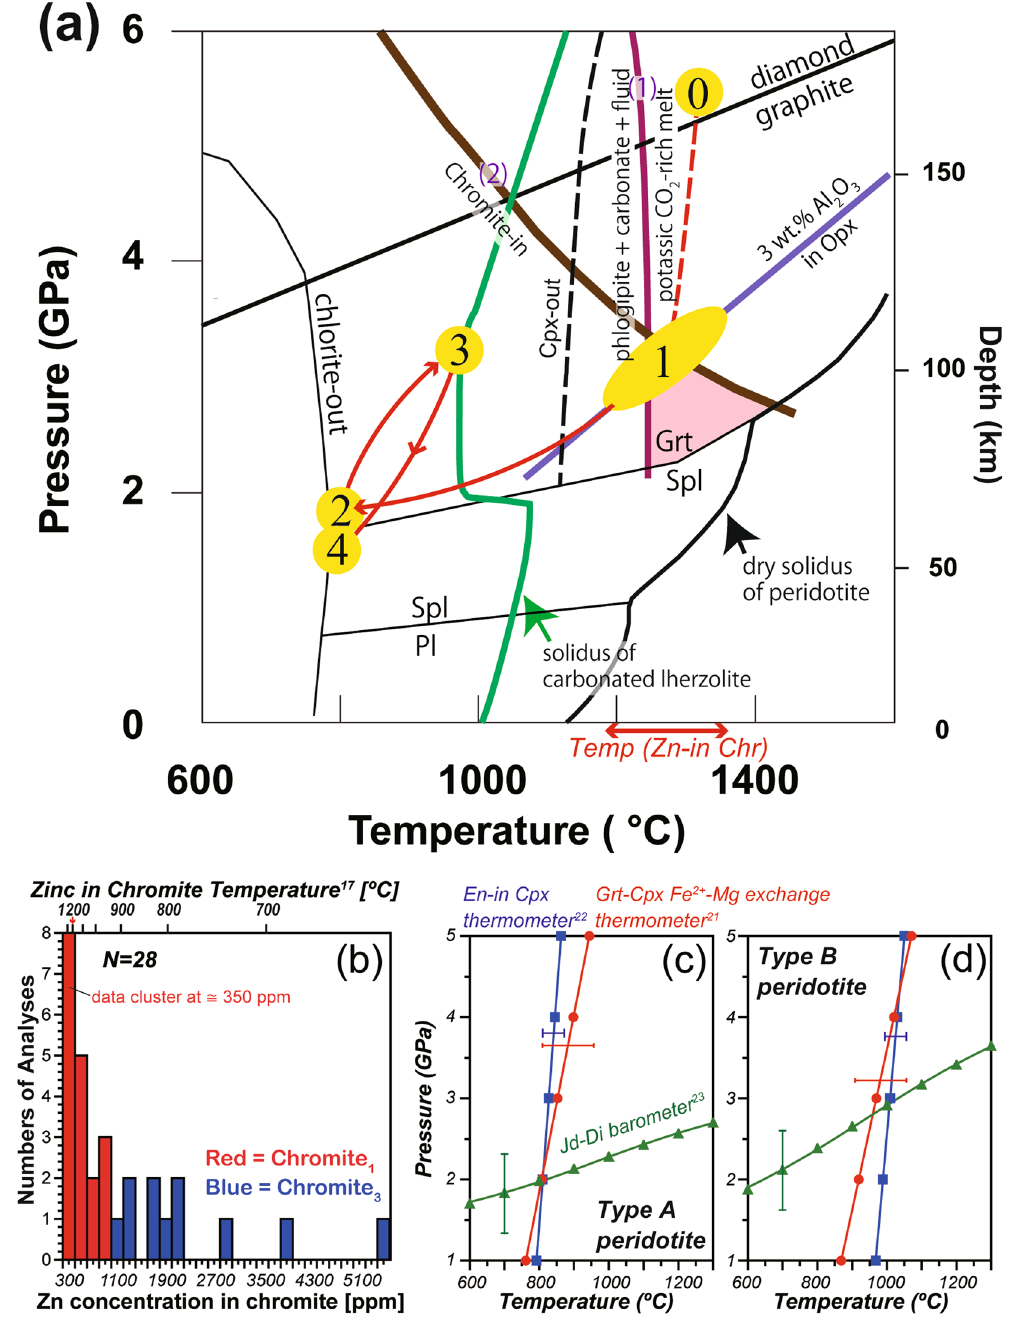
Figure 1. Panel (a) shows a pressure–temperature path of the Plešovice peridotite, which consists of four stages represented by yellow circles. The decarbonation reaction, recording the breakdown of phlogopite + magnesite (1) is from ref. 32 , and the chromite (Chr)-in reaction (2) for depleted lherzolite from ref. 31 . The graphite– diamond transition is from ref. 65 . The solidus for metasomatized peridotite is from ref. 30 clinopyroxene (Cpx)- out curve is from ref. 20 other phase boundaries are after ref. 7 and references therein. Pl = Plagioclase 16 . In panel (b) Zn concentrations of Chr are summarized. Zn concentration of Chr 1 grains included in garnet (Grt) are 300–950 ppm, and those of matrix Chr 3 are 1200–5600 ppm. Zinc-in-chromite temperatures 17 are shown on the upper axis. Panels (c) and (d) are results of thermobarometric calculations for Type A and B peridotites, respectively. The Grt–Cpx thermobarometers of refs 21–23 have been